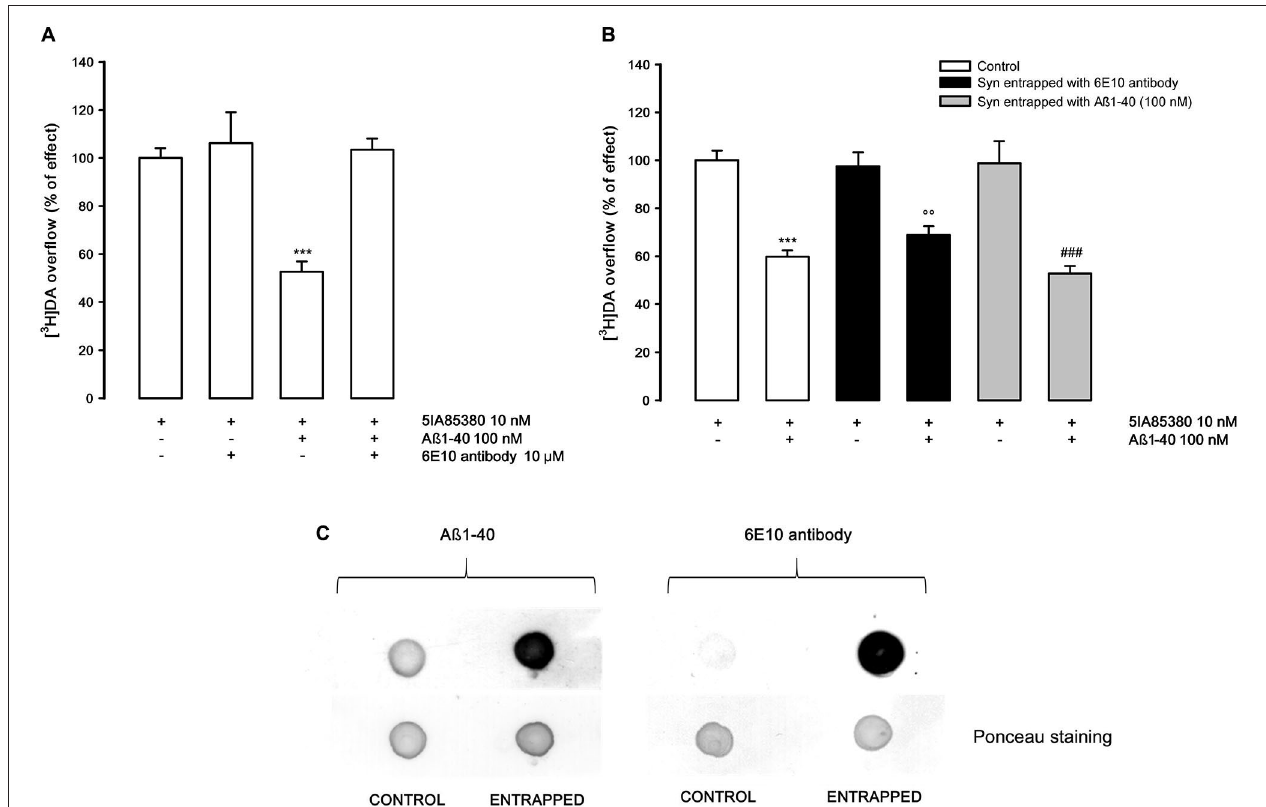
run in triplicate, *** P < 0.001 versus 5IA85380 (control synaptosomes), ◦◦ P < 0.01 versus 5IA85380 (6E10 antibody entrapped); ### P < 0.001 versus 5IA85380 (A β 1-40 entrapped). Two-way ANOVA followed by Bonferroni post-hoc test. (C) Representative dot blot of rat NAc